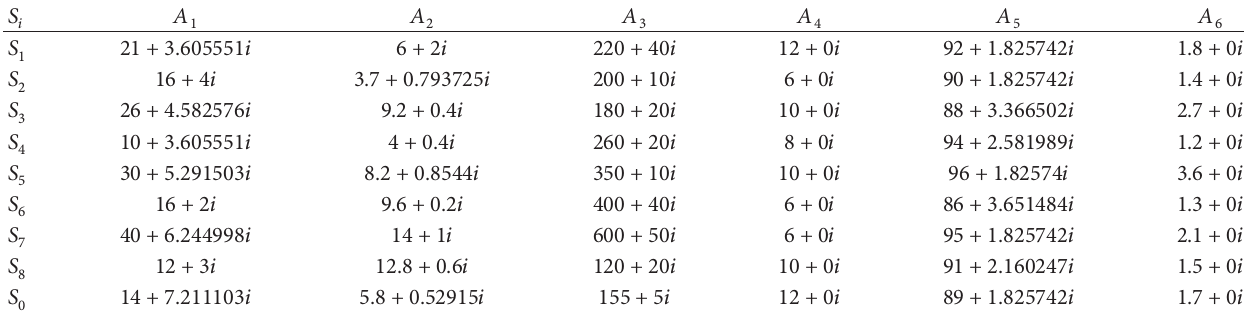
Table 3: Index vectors transformed from index values.